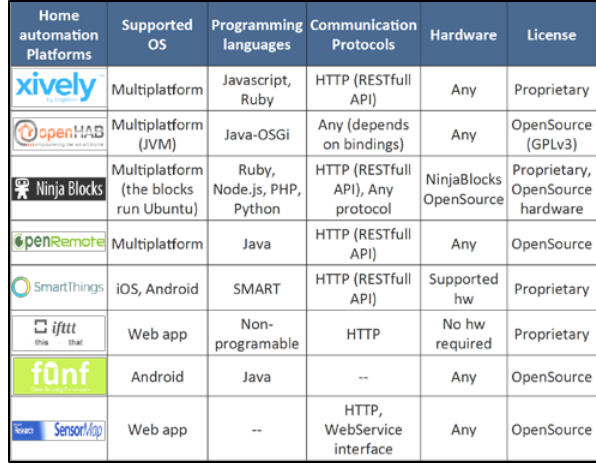
Table 1. Comparative Analysis for Home Automation and Sensing